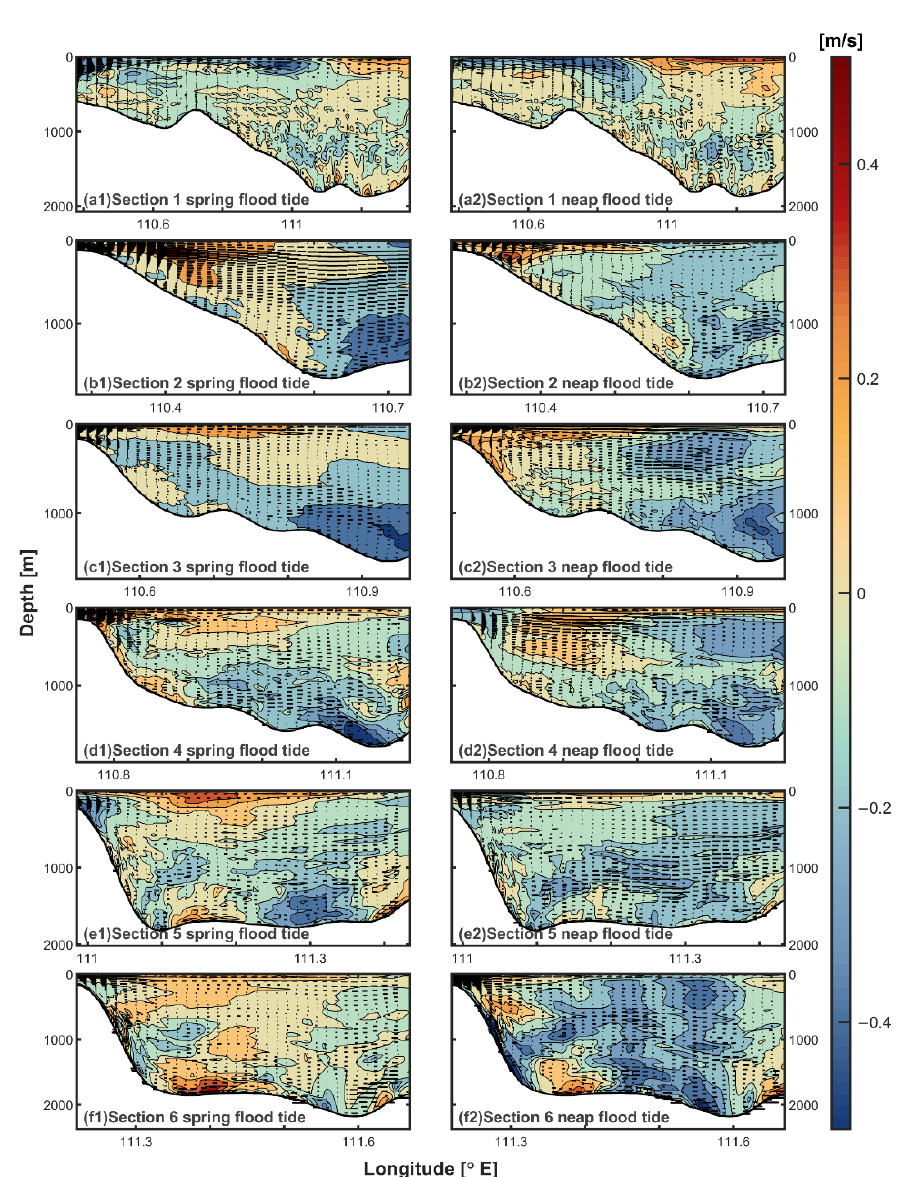
Figure 5. Distribution of flow velocity in Sections 1–6 of Figure 1c. The left and right columns represent peak flood of the spring tide (UTC 2020-07-19 07:00) and the neap tide (UTC 2020-07-28 06:00), respectively. Contours show the magnitude of the cross-sectional flow velocity, where positive values represent water inflow and negative values represent water outflow. The direction and length of arrows represent the direction and velocity, respectively, of the along-section water flow.